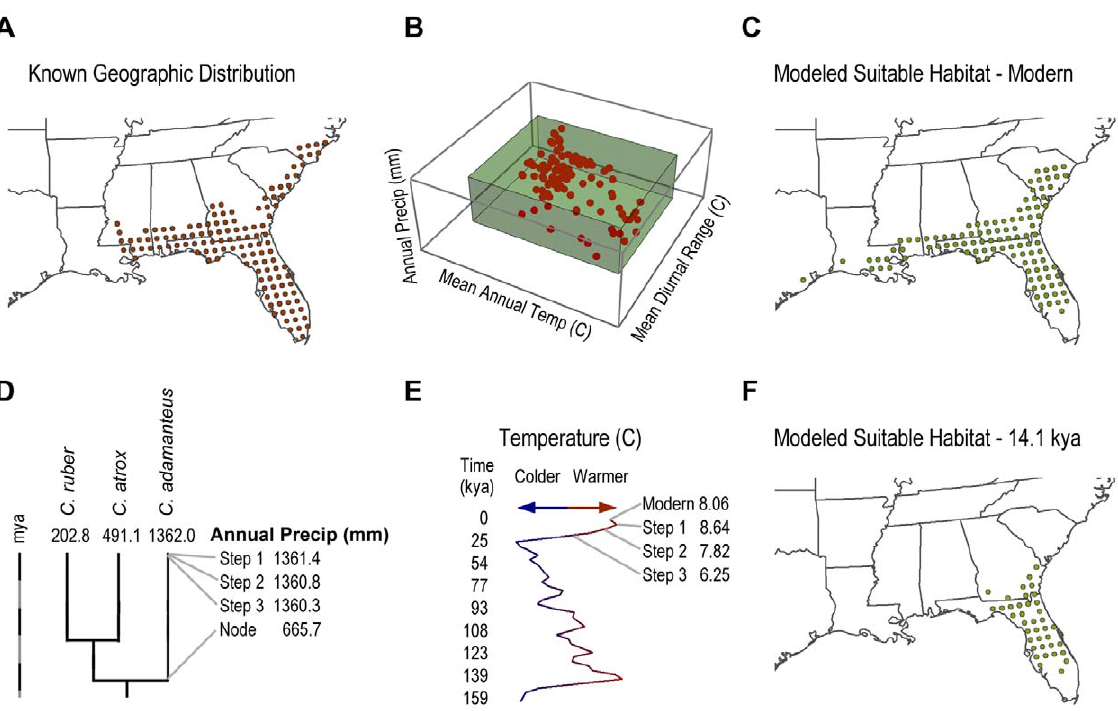
Figure 2. Illustration of a paleophylogeographic model. A, Modern geographic distribution for Crotalus adamanteus . B, Climate envelope for three bioclimatic variables. The red points represent the climate associated today with each red 50 km point from the modern geographic distribution in A. The green cube represents the climate envelope, the 5 th and 95 th percentile of each of the three bioclimatic variables. C, Suitable habitat modeled from the climate envelope on the modern climate. The green 50 km points on the map all fall within the green climate space in B and are considered suitable habitat for C. adamanteus today. D, Phylogeny and ancestral reconstructions. Annual Precipitation (mm) is regressed on the phylogeny. The first three steps of the reconstruction are shown at 4.7 kya, 9.4 kya and 14.1 kya. E, Temperature estimates for the North American continent derived from a composite oxygen isotope curve. The paleoclimate reconstruction for each step is scaled based on this curve. F, Phylogenetically scaled climate envelope projected onto isotopically scaled paleoclimate model at 14.1 kya. These 50 km points are considered suitable habitat for C. adamanteus 14.1 kya.